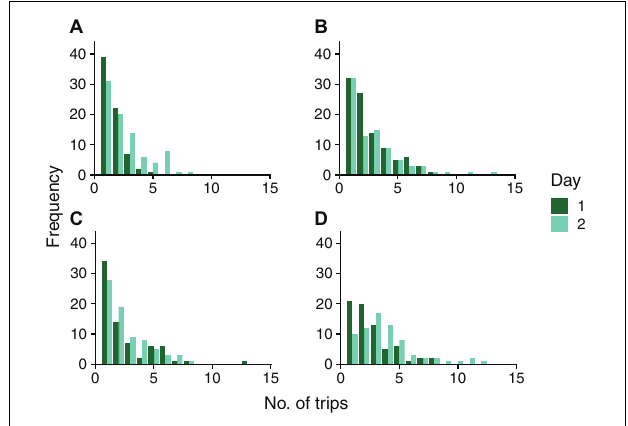
FIGURE 3 | Frequency distribution of number of foraging trips on two consecutive days in colonies 859 (A) , 1107 (B) , 1242 (C) , and 1368 (D) . Dark green bars represent Day 1; light green bars represent Day